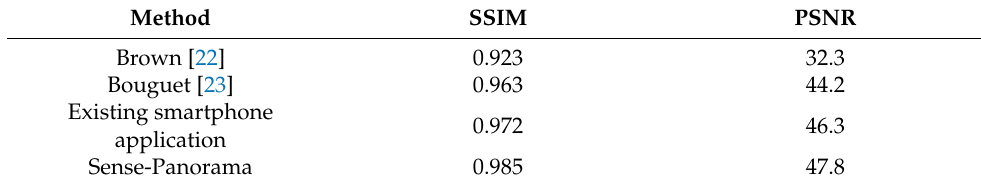
Table 6. Objective quality matrices comparison.